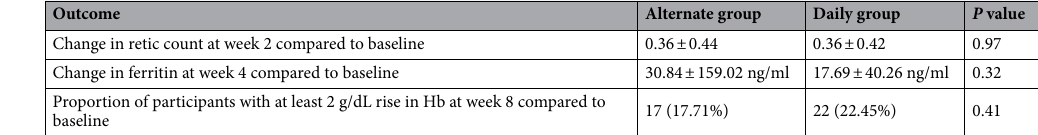
Outcome Alternate group Change in retic count at week 2 compared to